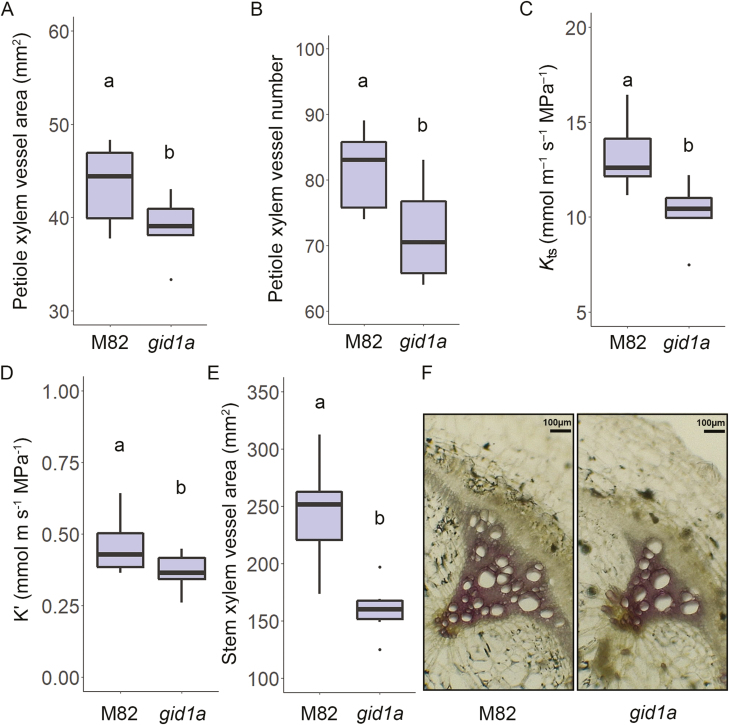
The loss of GID1a reduces xylem vessel proliferation and hydraulic conductance. (A, B) Total xylem vessel area (A) and xylem vessel number (B) in the base of the leaf petioles of M82 and gid1a (leaf no. 4, top down). (C) Theoretical specific hydraulic conductance (Kts) of the xylem vessels in M82 and gid1a. For calculation of Kt, the Hagen–Poiseuille equation (Tyree and Ewers, 1991) was used. To calculate Kts, Kt was normalized to the supported leaf area (Hochberg et al., 2015). (D) Volumetric-flow rate was measured in detached stem segments, taken from 4-week-old M82 and gid1a plants to calculate the actual hydraulic conductance (K′). (E) Total xylem vessel area in M82 and gid1a stems. Data in (A– E) (taken from six different plants) are graphically presented as box and whisker plots. Lowercase letters represent significant differences between respective lines (Student’s t-test, P<0.05). (F) Representative stem (as in E) cross sections of M82 and gid1a stained with Wiesner stain. Scale bar: 100 μm.